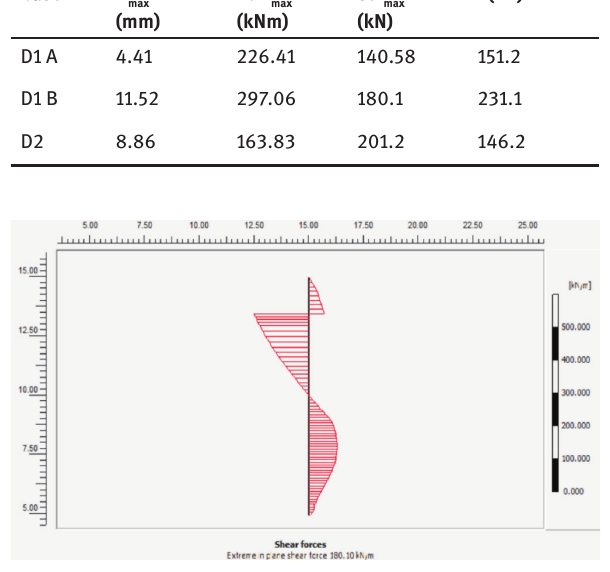
Figure 2: Maximum shear force developed on wall panel as per EC 7(D1 B).